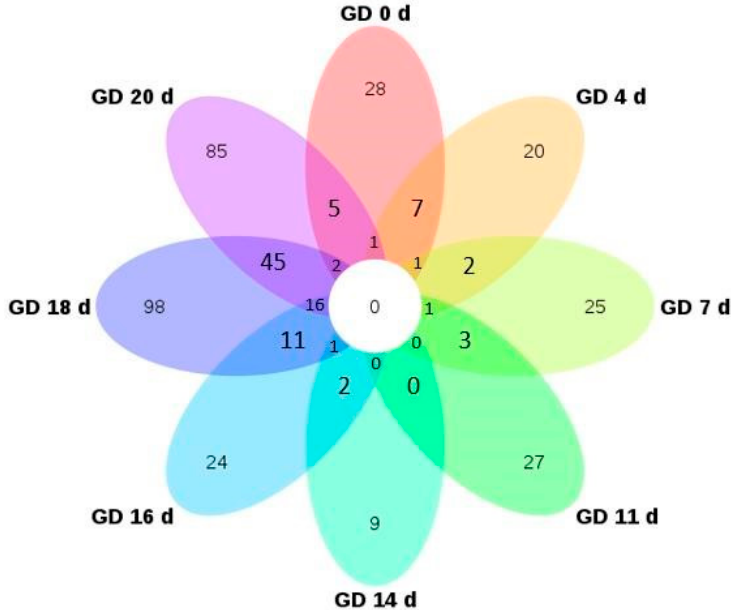
Figure 2. Venn diagram of differential proteins in the pregnant group.